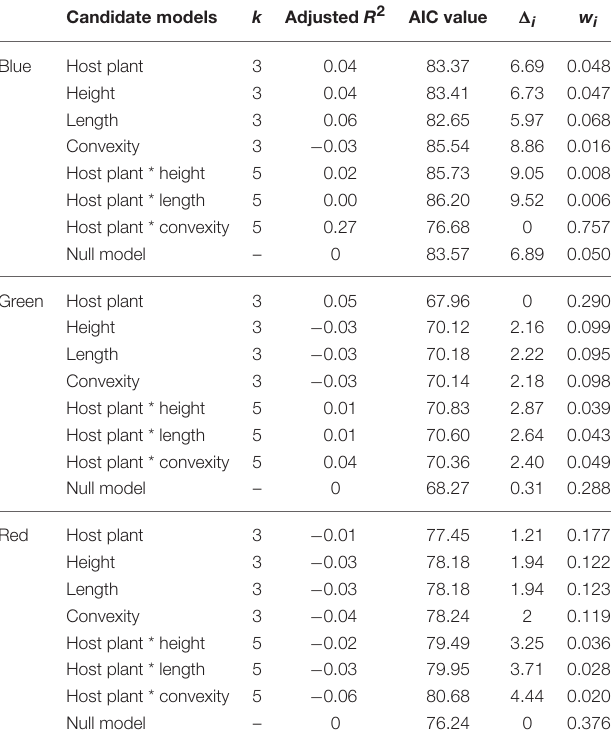
TABLE 5 | Effect of host plant and beetle morphology on color pattern differences.